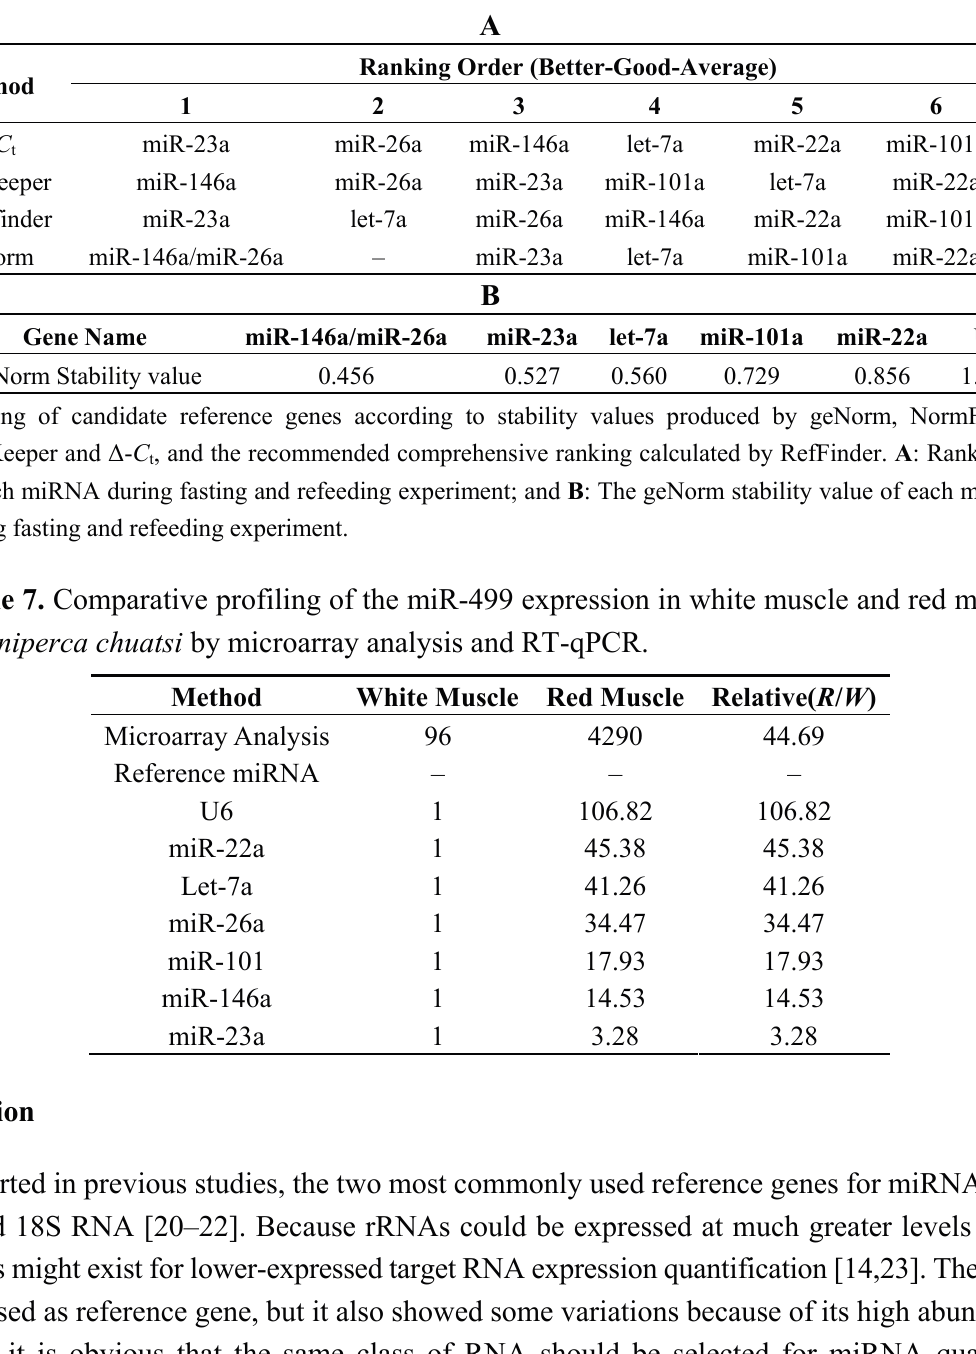
Table 6. Ranking of candidate reference miRNAs and U6 during fasting and refeeding experiment. Method